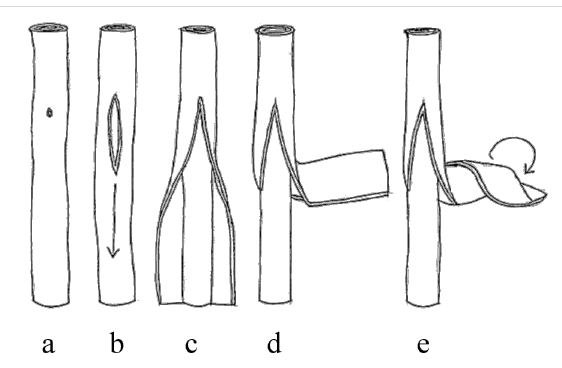
Figure 4: A schematic diagram of the suggested “unzipping” and “re- rolling” sequence: a) formation of unzipping point; b) onset of unzip- ping; c) unzipping and onset of peeling of inner parallel tubes; d) outer layers peeling out as a sheet; e) onset of re-rolling of outer layers.